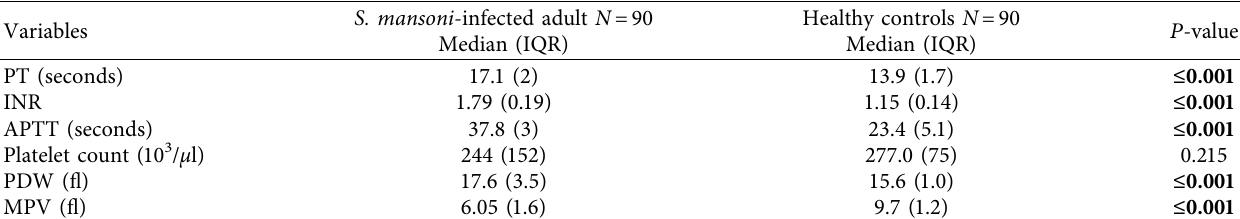
Table 3: Comparison of coagulation profiles and platelet parameters among S. mansoni -infected adults and noninfected individuals